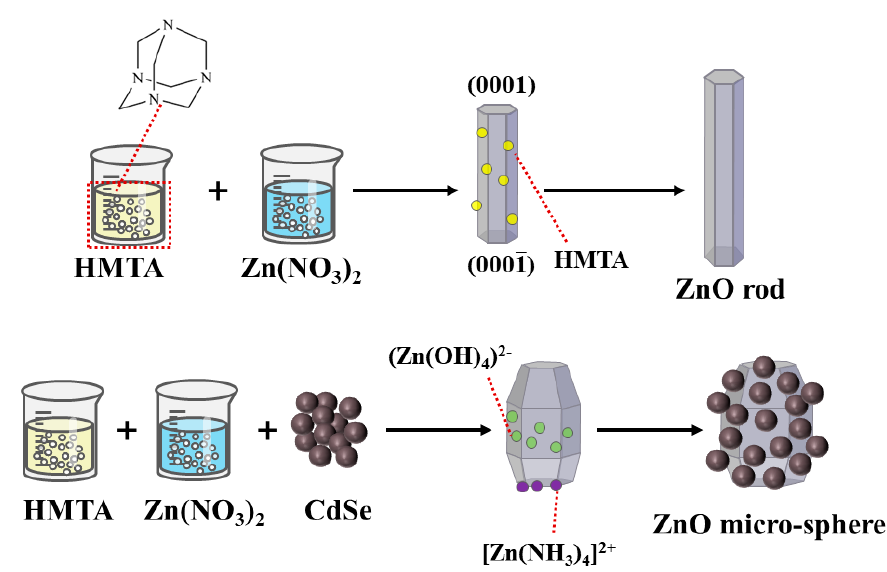
Figure 6. Schematic diagram of the ZnO rod and ZnO/CdSe micro − sphere growth mechanism.